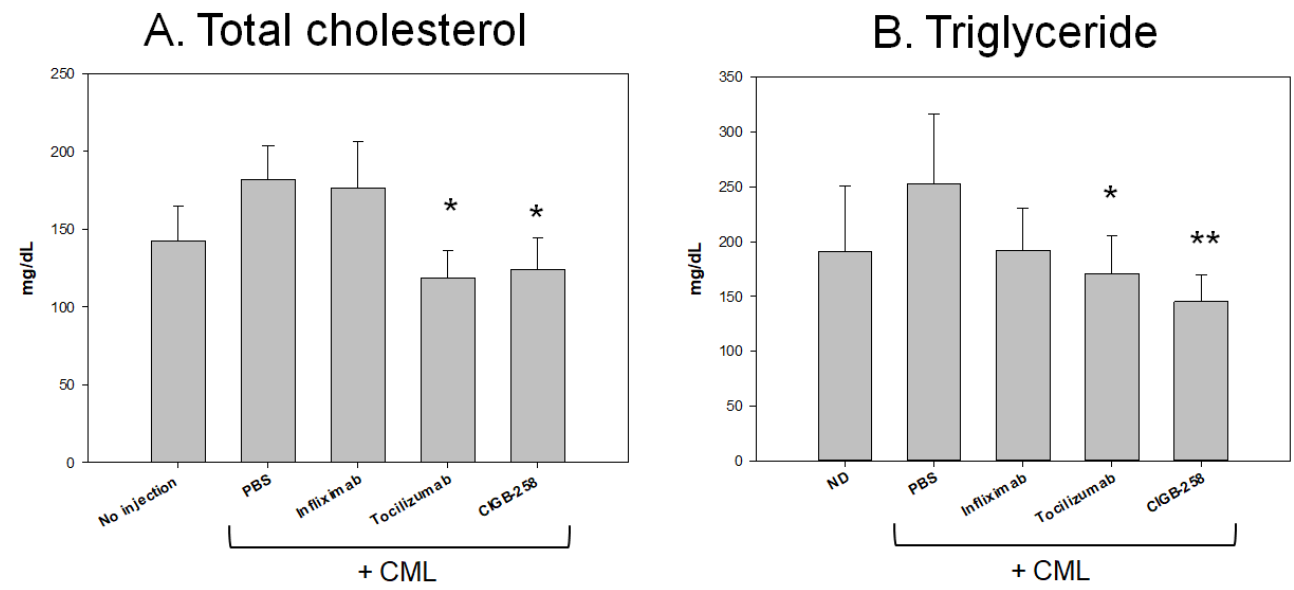
Figure 9. Quantification of lipid profiles from zebrafish injected with PBS, CIGB-258, Infliximab, and Tocilizumab in the presence of carboxymethyllysine (CML). * p < 0.05 versus PBS (CML alone) group; ** p < 0.01 versus PBS (CML alone) group. All zebrafish were sacrificed at 60 min post injection of each designated drug. ( A ) Quantification of total cholesterol (TC) levels at 60 min post injection. ( B ) Quantification of triglyceride (TG) levels at 60 min post